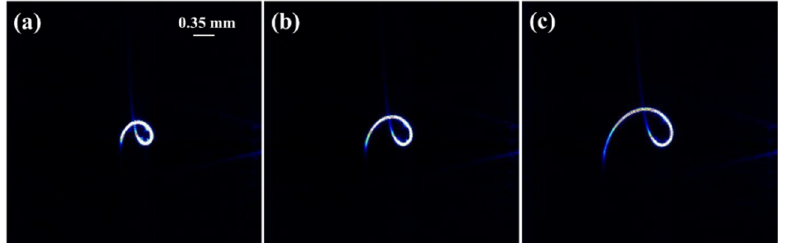
Figure 6. ( a – c ) CCD-captured intensity patterns of the spoon-like beams with l = − 5, n = 0.4, 0.5 and 0.6, respectively.